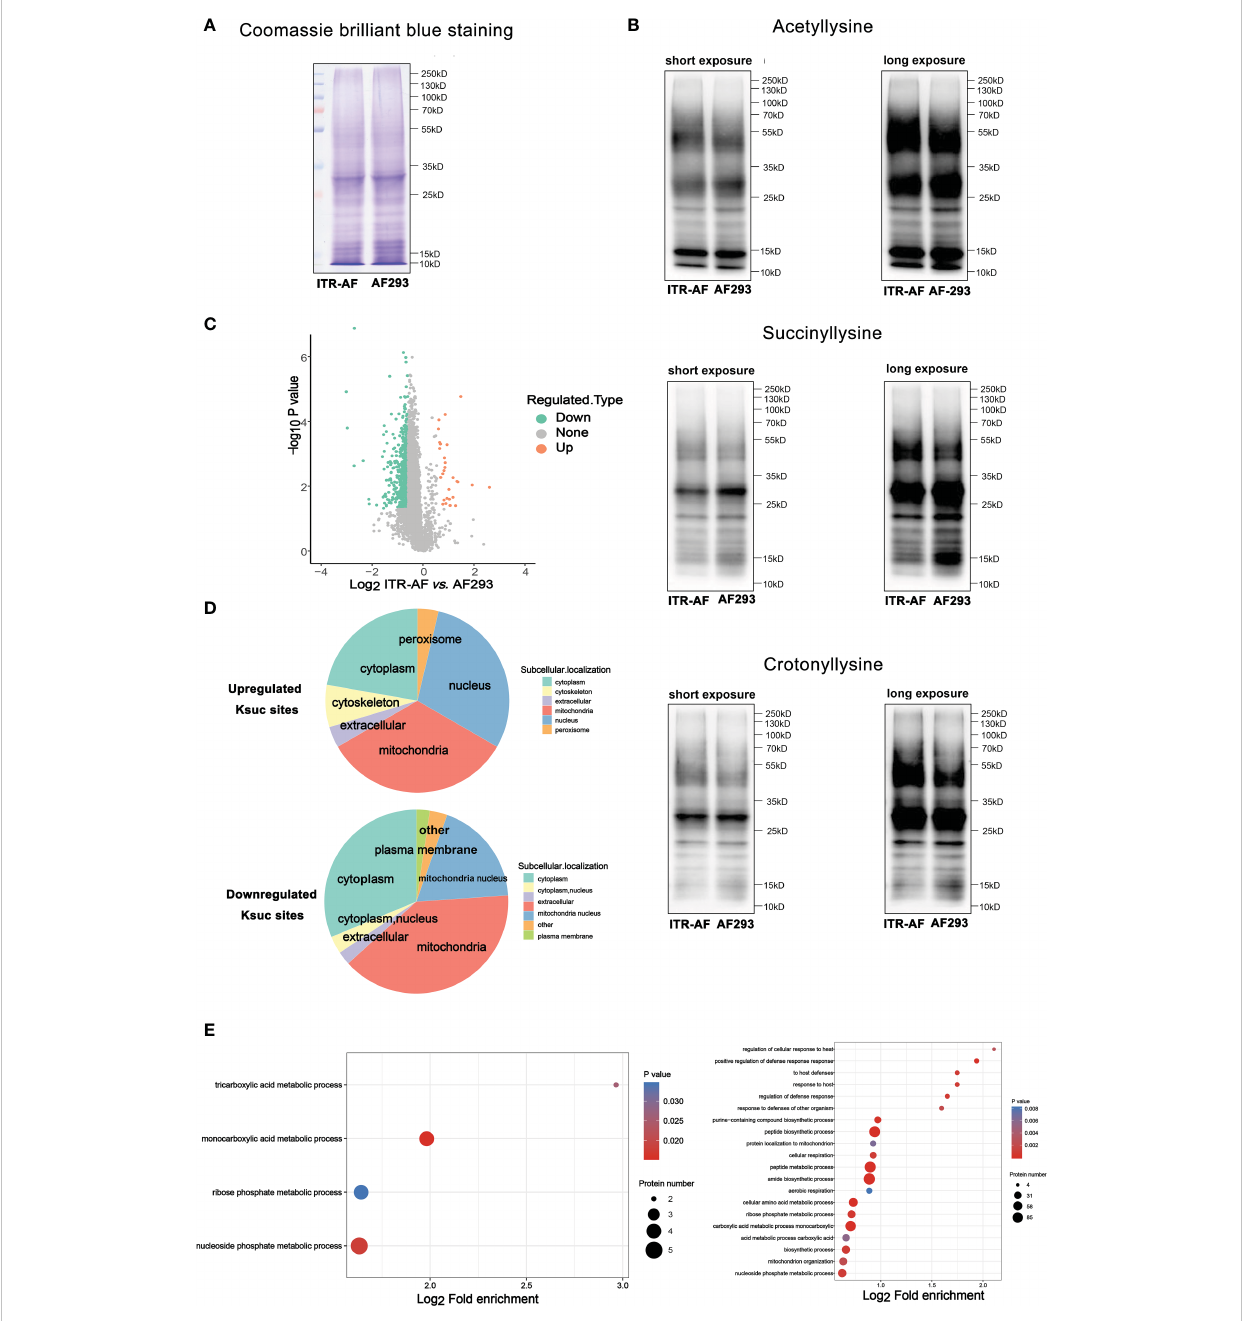
FIGURE 2 Proteome-wide analysis of lysine succinylation sites and proteins in A. fumigatus. (A) Coomassie brilliant blue staining of SDS – PAGE gel revealed the protein distribution in ITR-AF and AF293; (B) Western blotting revealed the acetyllysine, succinyllysine, and crotonylllysine level in ITR-AF and AF293; (C) Volcano plots depicting the differentially succinylated lysine sites in ITR-AF compared with that in AF293. P-value was calculated using a two- sided Wilcox rank-sum test; (D) Pie charts depicting the subcellular localization of differentially succinylated lysine sites in ITR-AF relative to that in AF293. P-value was calculated using a two-sided Wilcox rank-sum test; (E) Bubble charts describing the pathways (GO biological process) engaged with differentially succinylated lysine sites in ITR-AF when compared with that in AF293. The p-value was calculated using the hypergeometric